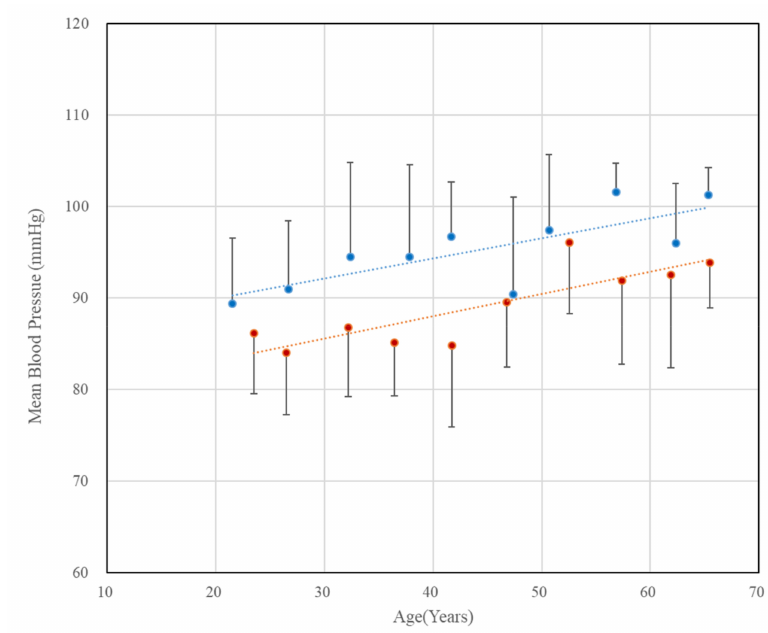
Figure 4. Chronological changes in mean blood pressure in both genders. The error bars represent the standard deviations (blue: males, r = 0.77, p = 0.009, red: females, r = 0.84, p = 0.002). Unlike the mean blood pressure, the pulse pressure shown in Figure 5 does not show a significant change with age. In the case of females, there was a tendency to increase with age (p < 0.05), but in males, there was no significant trend change according to age. Although it is generally known that arterial sti ff ness increases with age, previous study [17] did not show a significant correlation between pulse pressure and age for males. Thus, it is expected that the pulse pressure change of males does not match well with age.